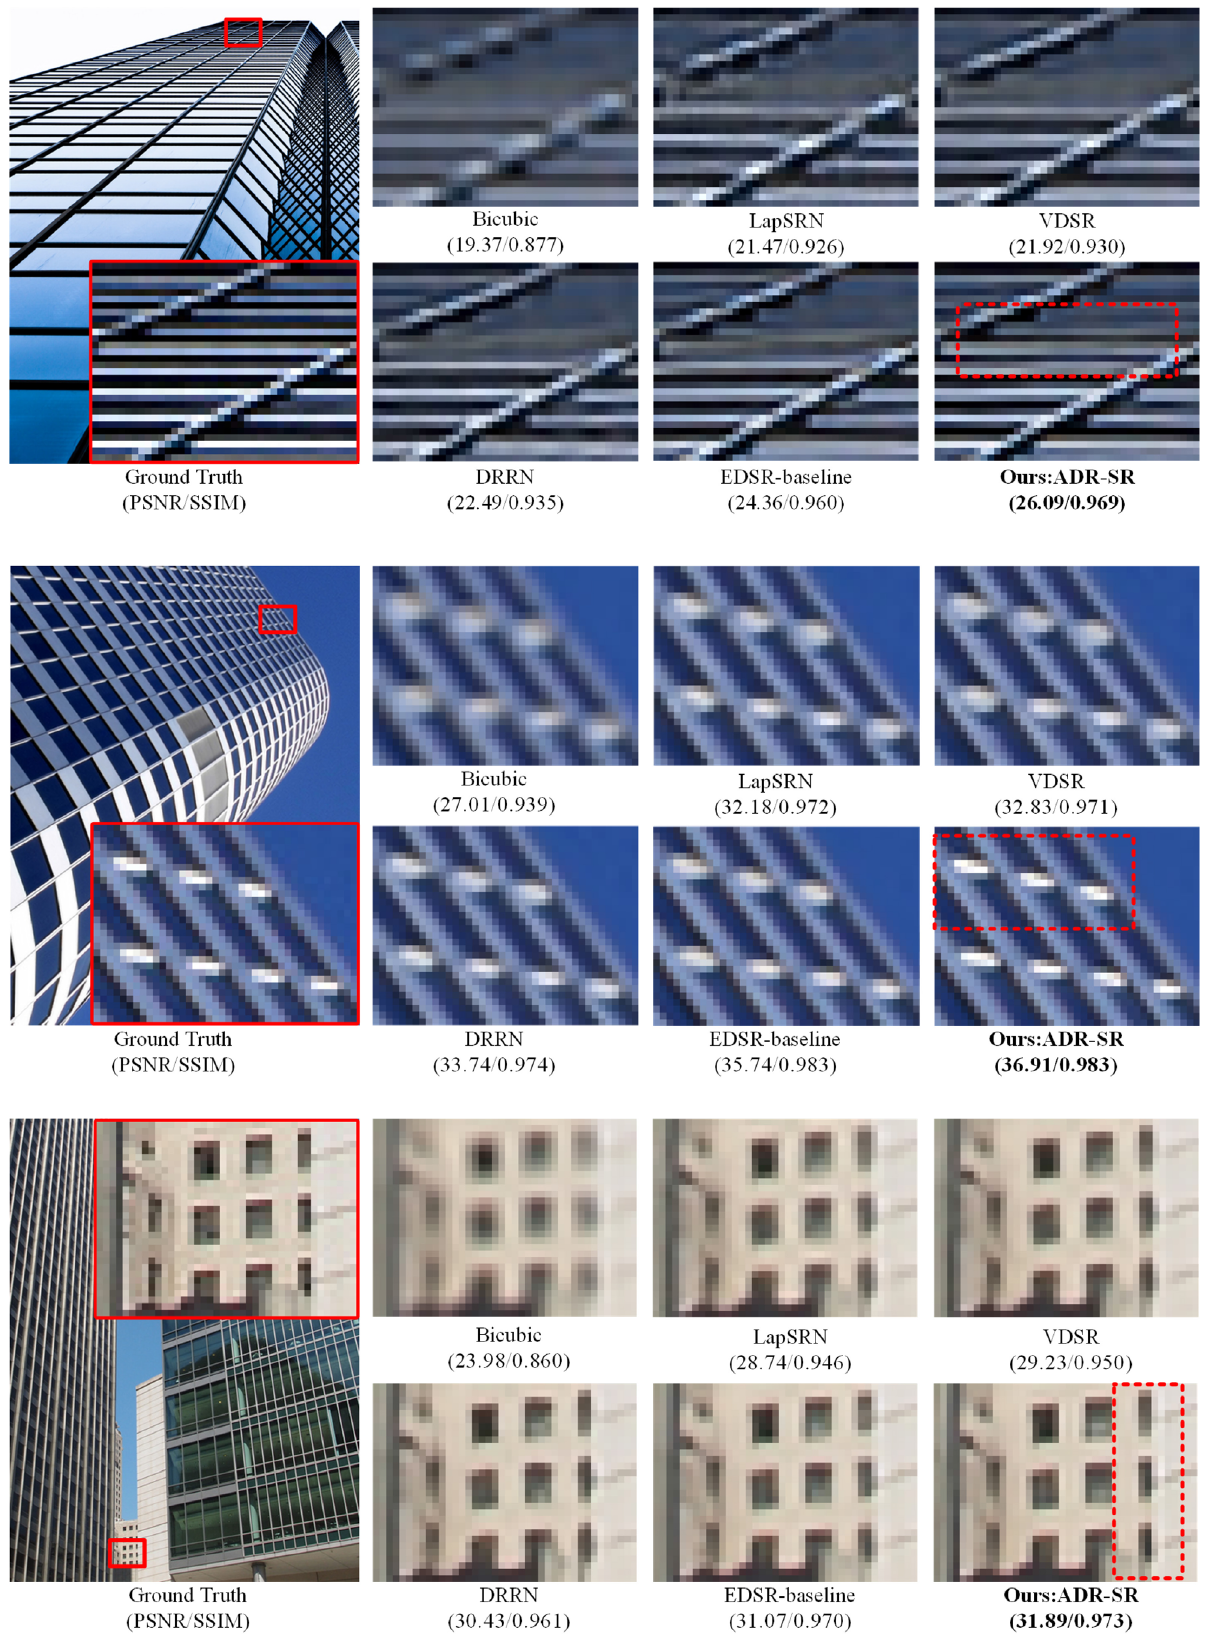
Fig. 6 Comparison of experimental effects of Urban100